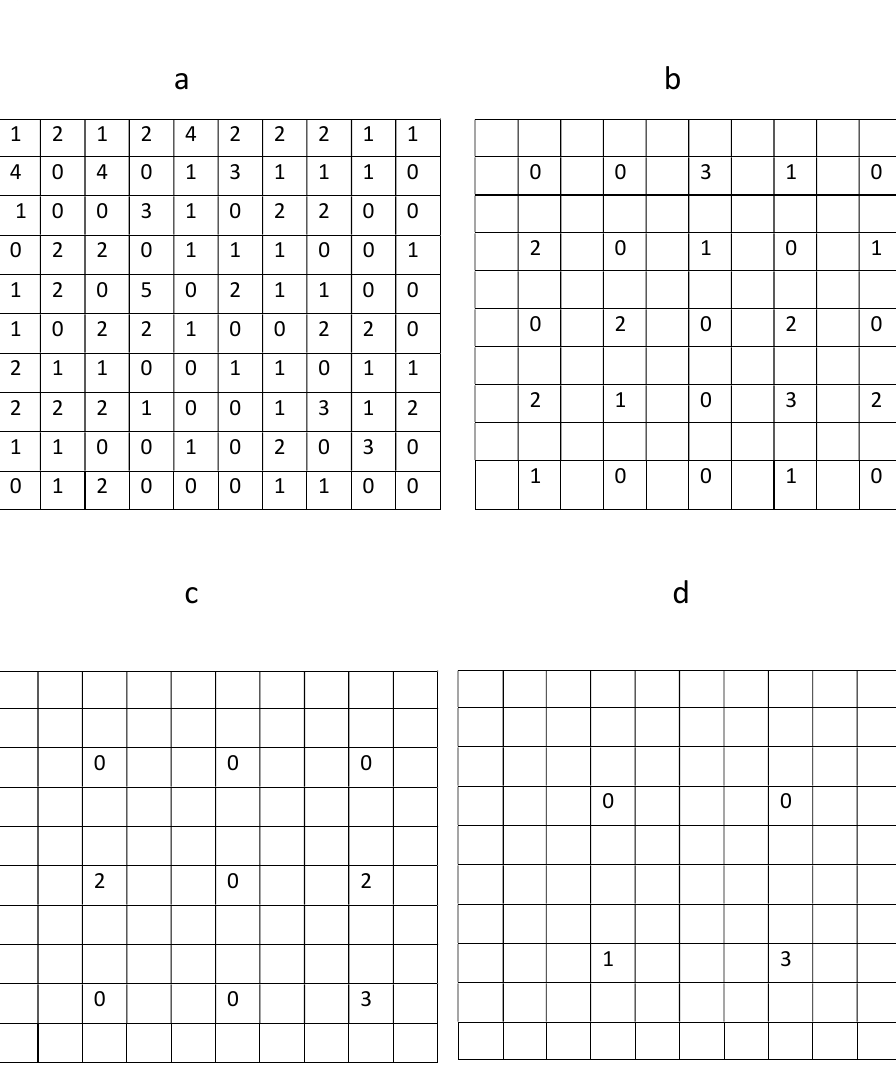
Figure 2. Trap counts on fine and coarse sampling grids. ( a ) Trap counts on the original sampling grid of 10 × 10 locations. ( b ) Trap counts on a hypothetical sampling grid of 5 × 5 locations. ( c ) Trap counts on a hypothetical sampling grid of 3 × 3 locations. ( d ) An extremely coarse sampling grid of 2 × 2 locations is generated from the original